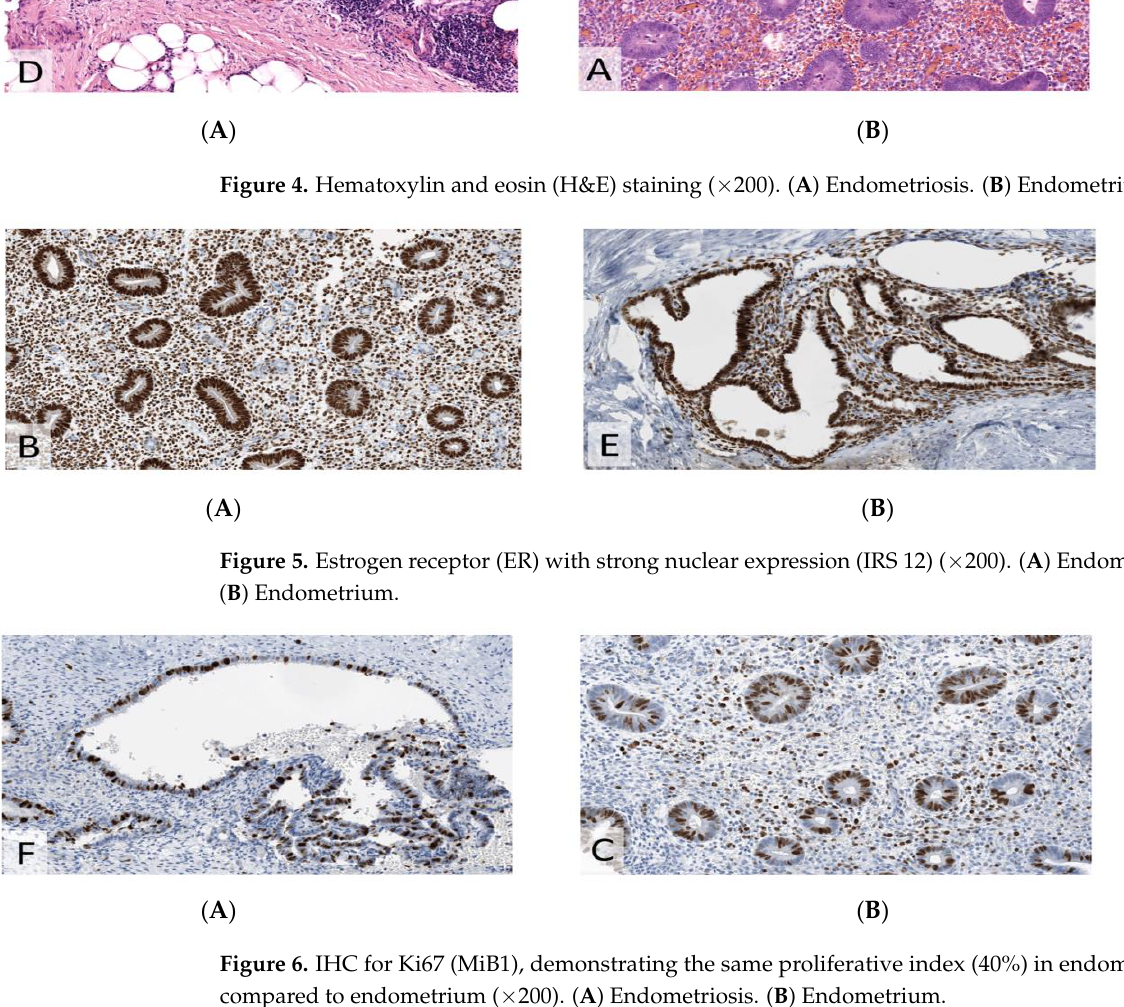
Figure 6. IHC for Ki67 (MiB1), demonstrating the same proliferative index (40%) in endometriosis compared to endometrium (×200). ( A ) Endometriosis. ( B ) Endometrium.